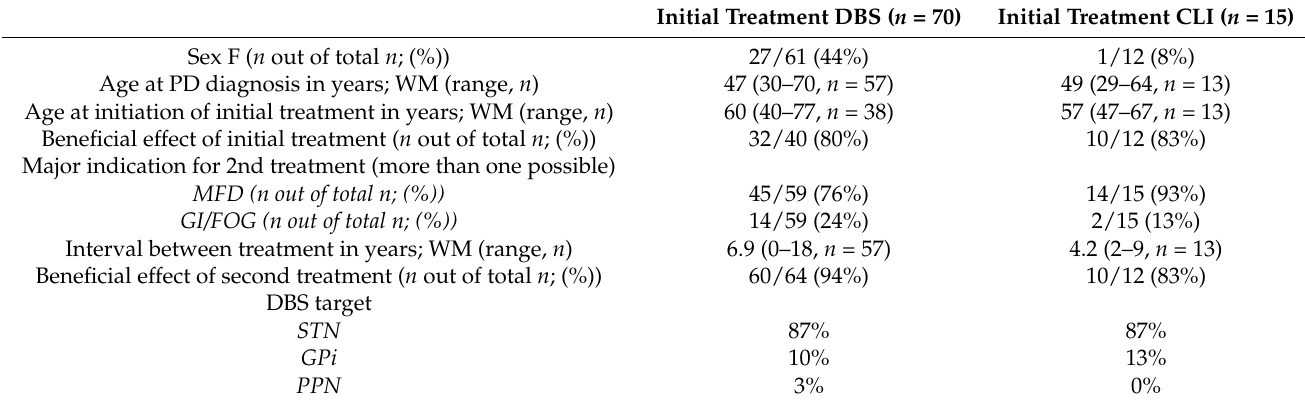
Table 1. Pooled results from currently presented and previously reported